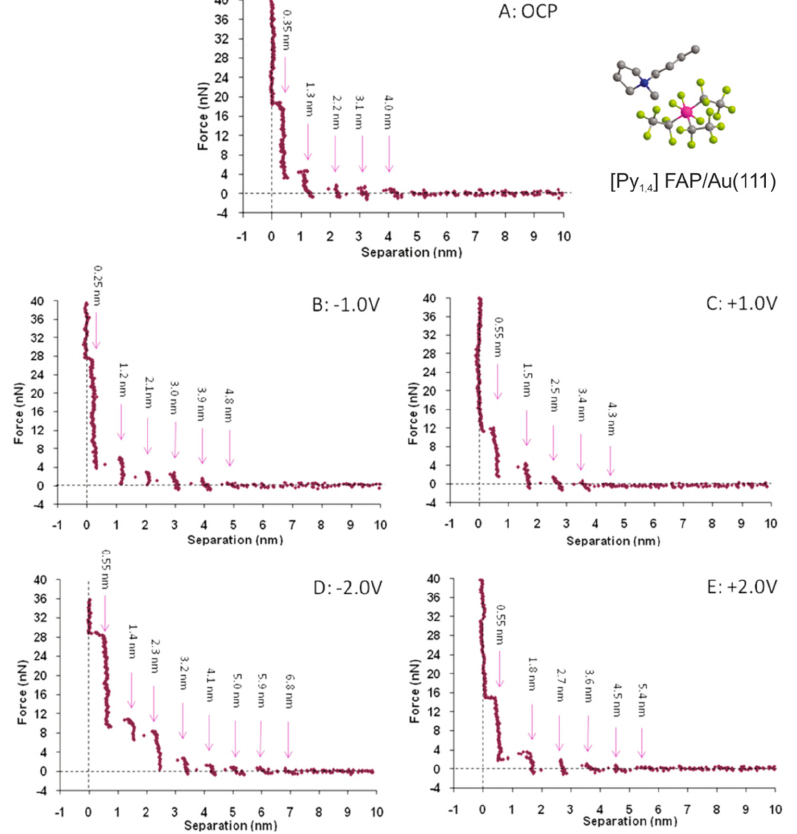
Figure 11. Force–distance measurements on the [Py 1,4 ] FAP/Au(111) interface at different surface potentials. Adapted with permission from Hayes et al. [89]. Copyright 2011, American Chemical Society.